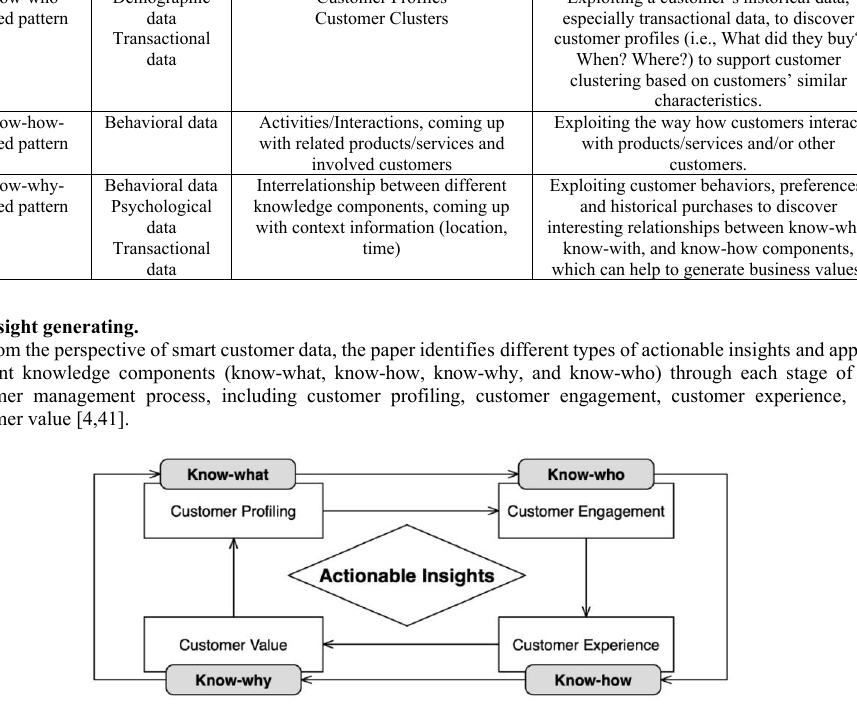
Fig. 2. Insight generating. Fig. 2. illustrates the knowledge component corresponding to each stage of the customer management process for generating actionable insights: Customer profiling, customer engagement, customer experience process, and customer value